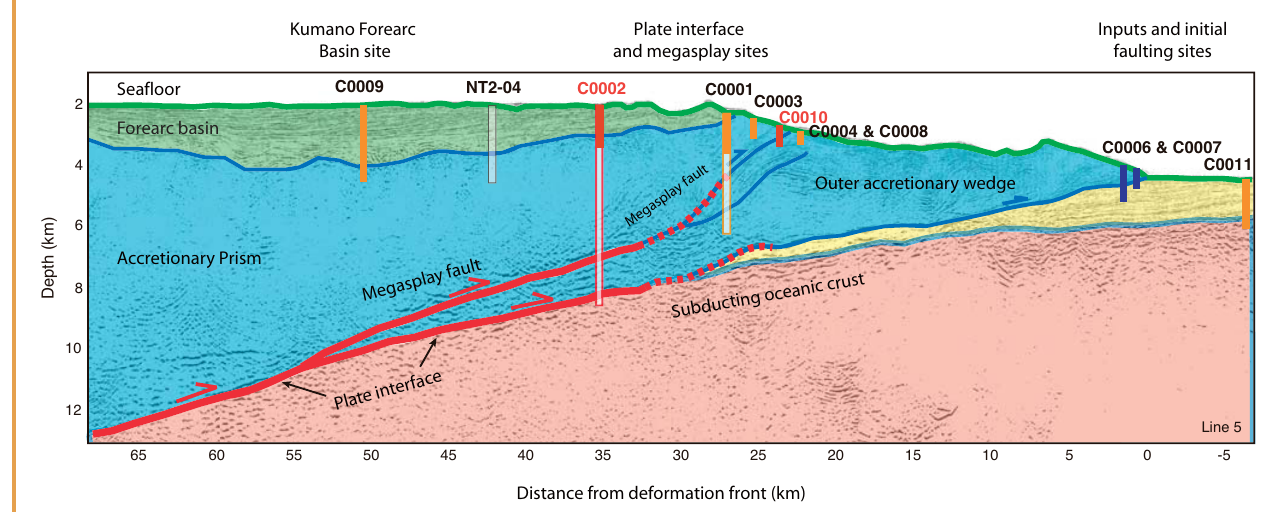
Figure 2. Interpreted seismic profile at regional scale showing interpretation by Park et al. (2002) and NanTroSEIZE drill sites. Sites C0002 and C0010 are indicated in red. All drill sites show current penetration (solid bars) and planned penetration (empty bars). represent a discontinuity in rock physical properties and a mechanical boundary between the inner and outer accre- tionary wedge and between aseismic and seismogenic fault behavior along the plate boundary (Wang and Hu, 2006). At depth, the megasplay is imaged in seismic reflection data as a high-amplitude reflector (Fig. 2; Bangs et al., 2009), and it branches into a family of smaller splays in the upper few kilo-